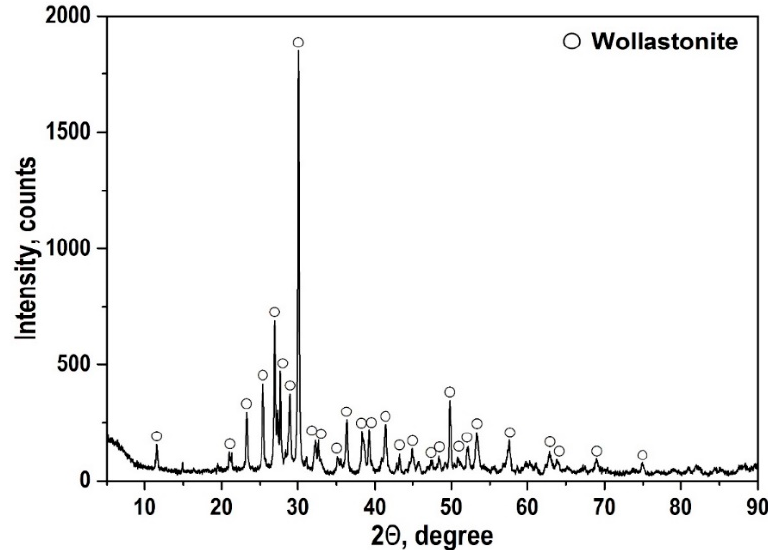
Figure 3. Phase composition of the autoclave synthesis product at 220 ◦ C in the multicomponent system CaSO 4 · 2H 2 O–SiO 2 · n H 2 O–KOH–H 2 O after calcination at 900 ◦ C.